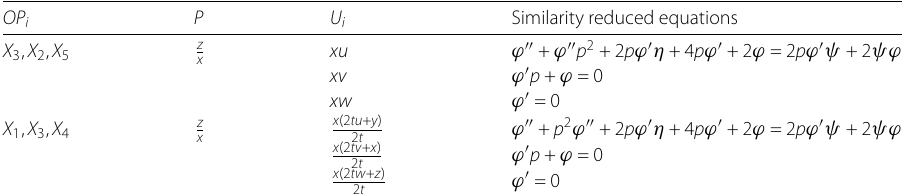
Table 1 Some similarity reduced equations OP i P U i Similarity reduced